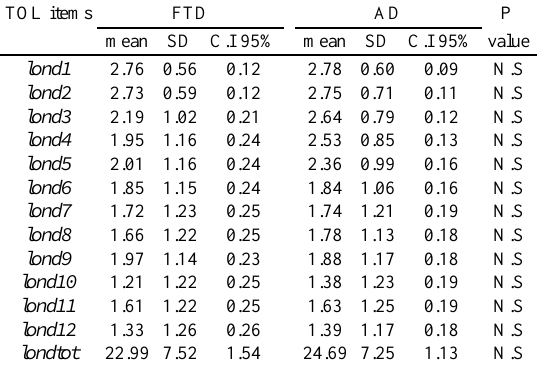
Table 2 Comparison of TOL individual items in the two diagnosis group: (SD = standard deviation; C.I. = Confidence Interval)